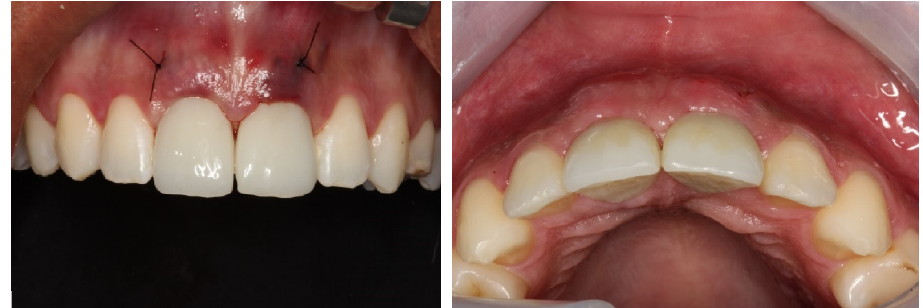
Figure 11. Surgical follow-up after 7 days, showing total tissue preservation.